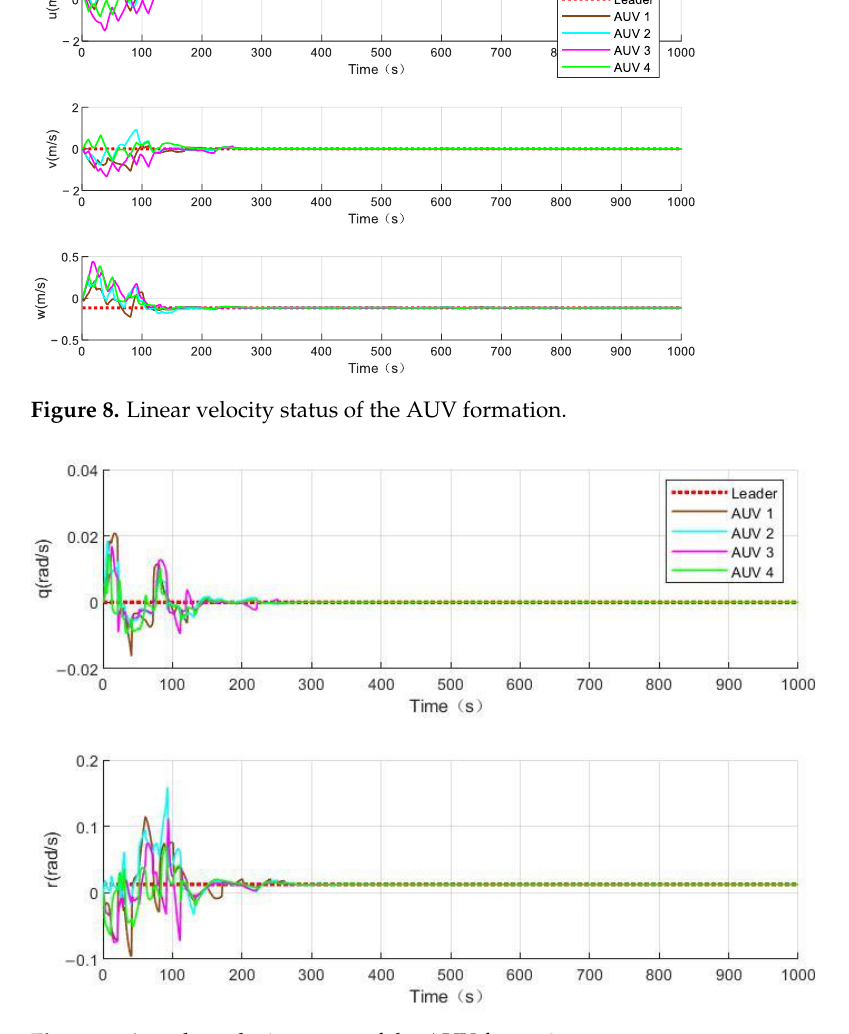
Figure 9. Angular velocity status of the AUV formation.